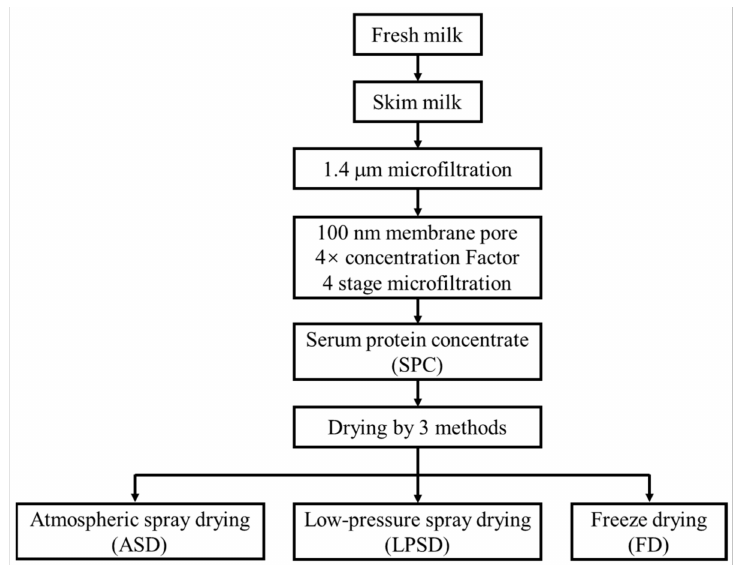
Figure 1. Schematic workflow of the preparation of the